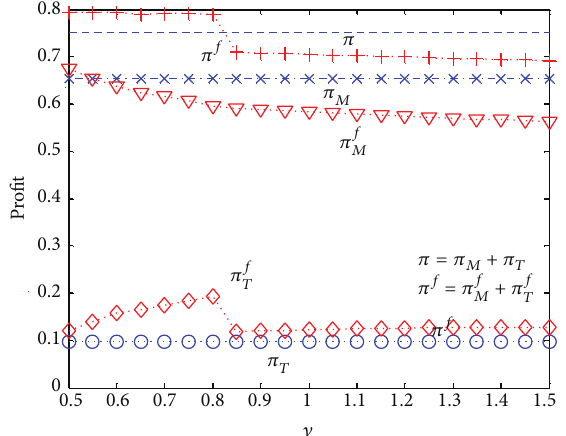
Figure 4: Effect of fairness channel profit distribution on channel profits.